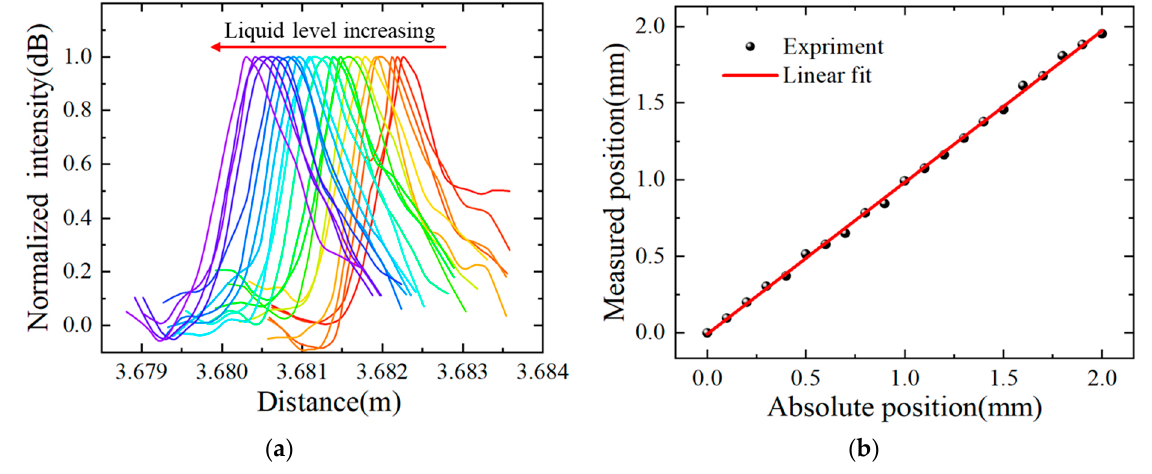
Figure 10. Liquid-level sensor in a range of 2 mm with an interval of 0.1 mm. ( a ) Normalized reflection peak drift with liquid level; ( b ) linear fit of measured position and absolute position of liquid level.